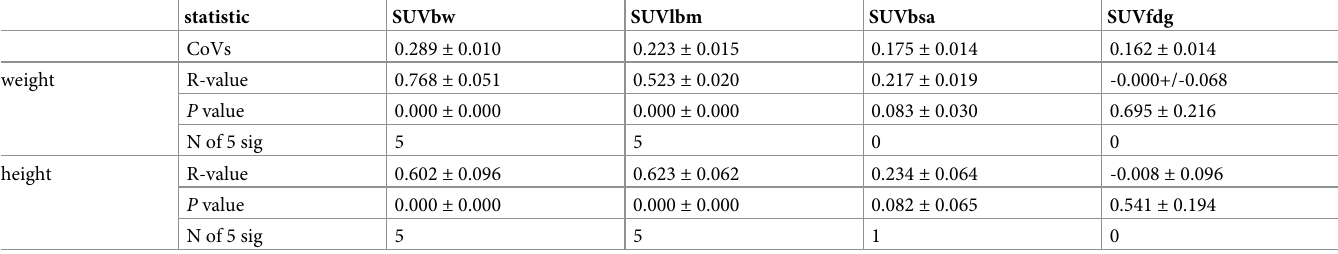
Table 2. Cross validation results.